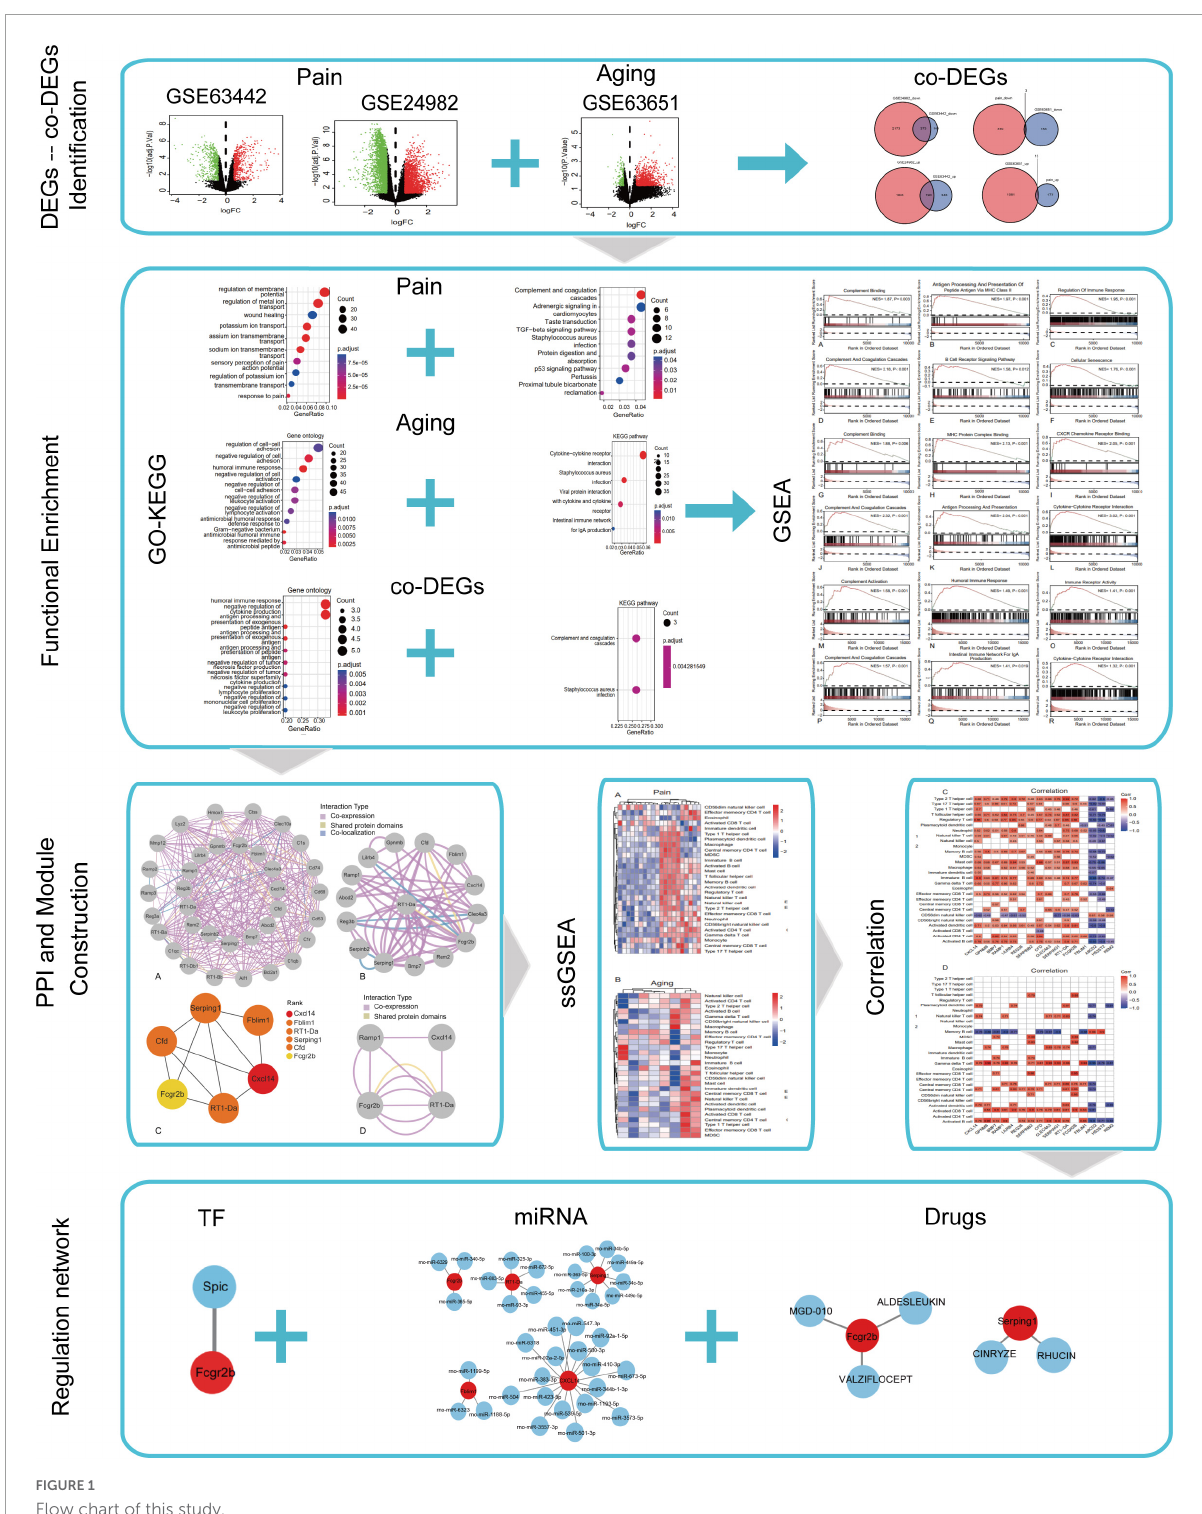
FIGURE1 Flow chart of this